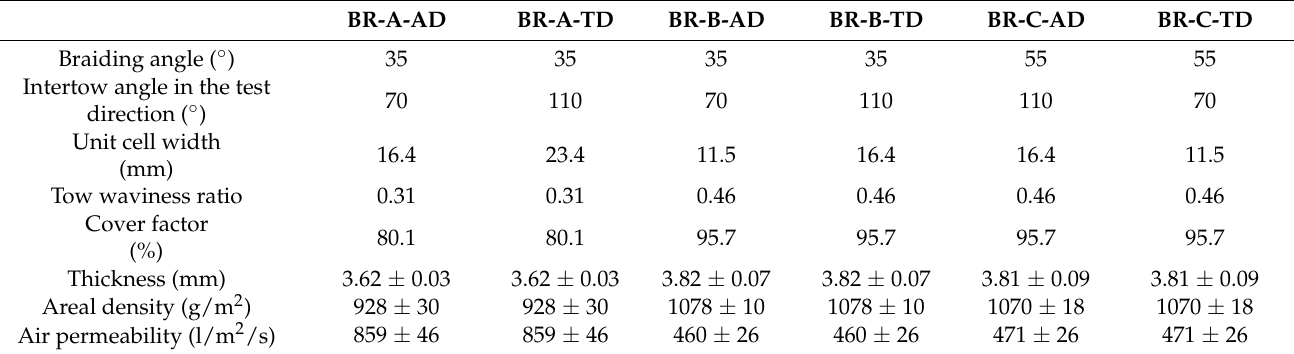
Figure 7. Illustrations of the six braided specimens. Table 1. The main properties of one-layer braided preform